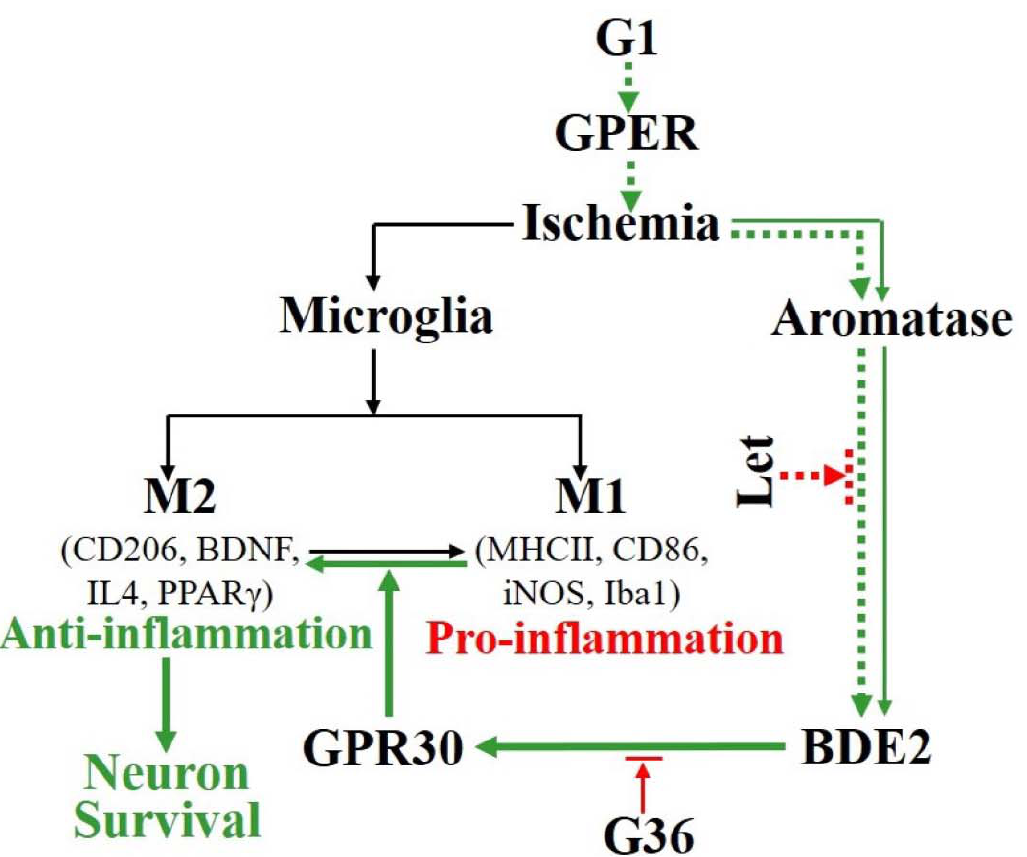
Figure 7. Summary diagram of the proposed mechanism underlying the synergistic regulation of microglial polarization induced by G1 and BDE2 that attenuates neuronal impairment in the ovariectomized rat hippocampal CA1 region following GCI. Cerebral ischemia induces Aro ‐ BDE2, which promotes protein expression of M2 markers via GPER, as evidenced by the inhibition caused by GPER antagonist G36. GPER activation induced by G1 reverses microglial polarization from the pro ‐ inflammatory M1 to the anti ‐ inflammatory M2 phenotype after 1 and 3 days of reperfusion after GCI. Meanwhile, Aro ‐ BDE2 signaling induced by G1 is blocked by Let and decreases the protein expression of M2 phenotype markers. Together, both G36 and Let treatments decrease neuronal survival in the hippocampal CA1 region in the early stage of GCI. Aro, aromatase; GCI, global cerebral ischemia; BDE2, brain ‐ derived estrogen; GPER, G ‐ protein ‐ coupled estrogen receptor 1; Let, letrozole.